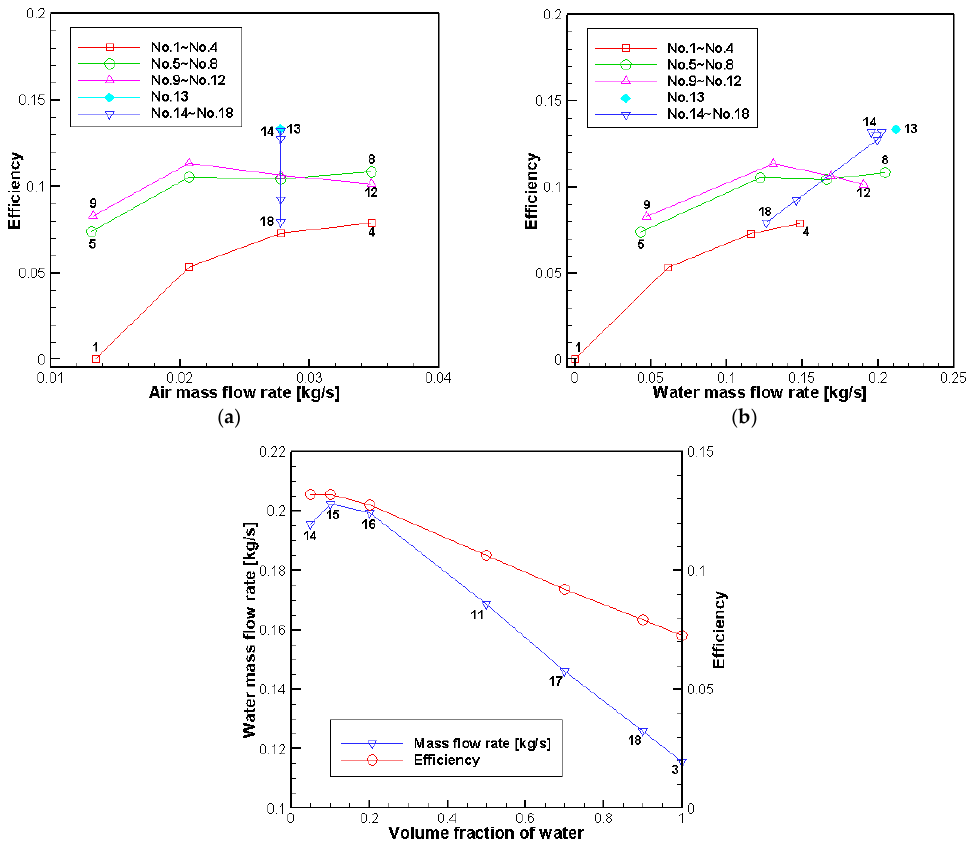
Figure 11. Comparison of efficiencies in terms of the mass flow rate and volume fraction for each case: ( a ) efficiency vs. air mass flow rate; ( b ) efficiency vs. water mass flow rate; and ( c ) efficiency and water mass flow rate versus volume fraction of water.